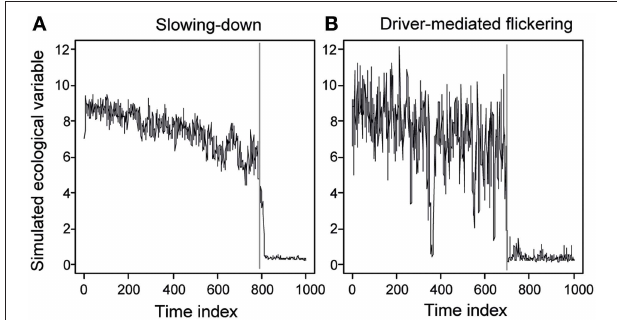
FIGURE 1 | Examples of single time series simulated from Equation (1) producing different patterns according to variations in c and σ . (A) represents a slowing-down scenario for which c increases over time with a low level of noise (small σ ). (B) refers to a driver-mediated flickering scenario for which c increases over time with a high level of noise (high σ ). The gray vertical lines indicate the time at which an observed bifurcation occurs toward a lower alternative stable state using the constrained hierarchical clustering based on Euclidian